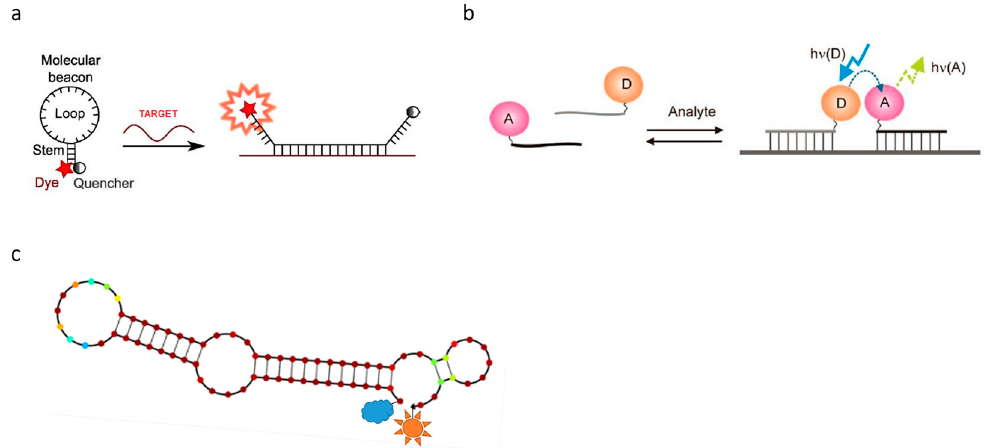
Figure 2. Design of FRET probes for nucleic acid detection: molecular beacons ( a ); binary probes ( b ); RNA aptamer labelled with fluorophore and quencher (shown as a star and cloud, respectively) ( c ). Molecular beacons (MBs) are single-stranded unimolecular oligonucleotides, typically 20–30